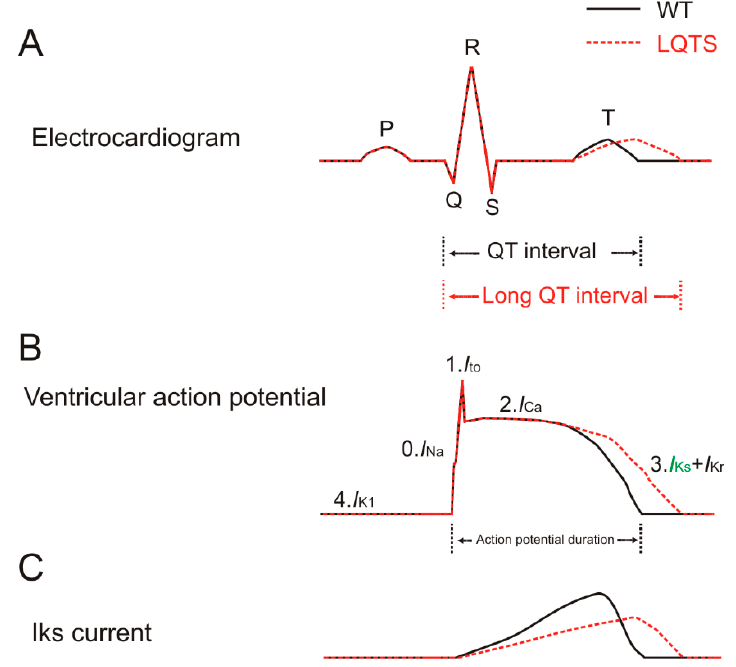
Figure 1. Long QT syndrome (LQTS) caused by a loss of the IKs current. Normal electrocardiogram, ventricular action potential and IKs current are depicted by black solid lines. The electrocardiogram, ventricular action potential and IKs current associated with LQTS are depicted by red dashed lines. Horizontal and vertical axes are not shown for clarity. ( A ) The electrocardiogram consists of five waves: P, Q, R, S and T waves. The P wave represents the depolarization of the atria. The QRS complex represents the rapid ventricular depolarization. The T wave represents the repolarization of the ventricles. The QT interval is the interval from the beginning of the Q wave to the end of the T wave. Patients with a prolonged QT interval can cause LQTS. Action potential duration is indicated. ( B ) The ventricular action potential consists of five phases, phase 0 to phase 4. Phase 0 is the depolarization phase that is mediated by an inward Na + current. Phase 1 is mainly mediated by a transient outward K + current. Phase 2 is the plateau phase that is mainly mediated by an inward Ca 2 + current and outward K + current. Phase 3 is the repolarization phase that is mainly mediated by outward K + (IKs in green and IKr) currents. Phase 4 is mainly mediated by an outward K + current (IK 1 ). ( C ) The IKs current underlies the repolarization of the ventricular action potential, shown as phase 3 in ( B